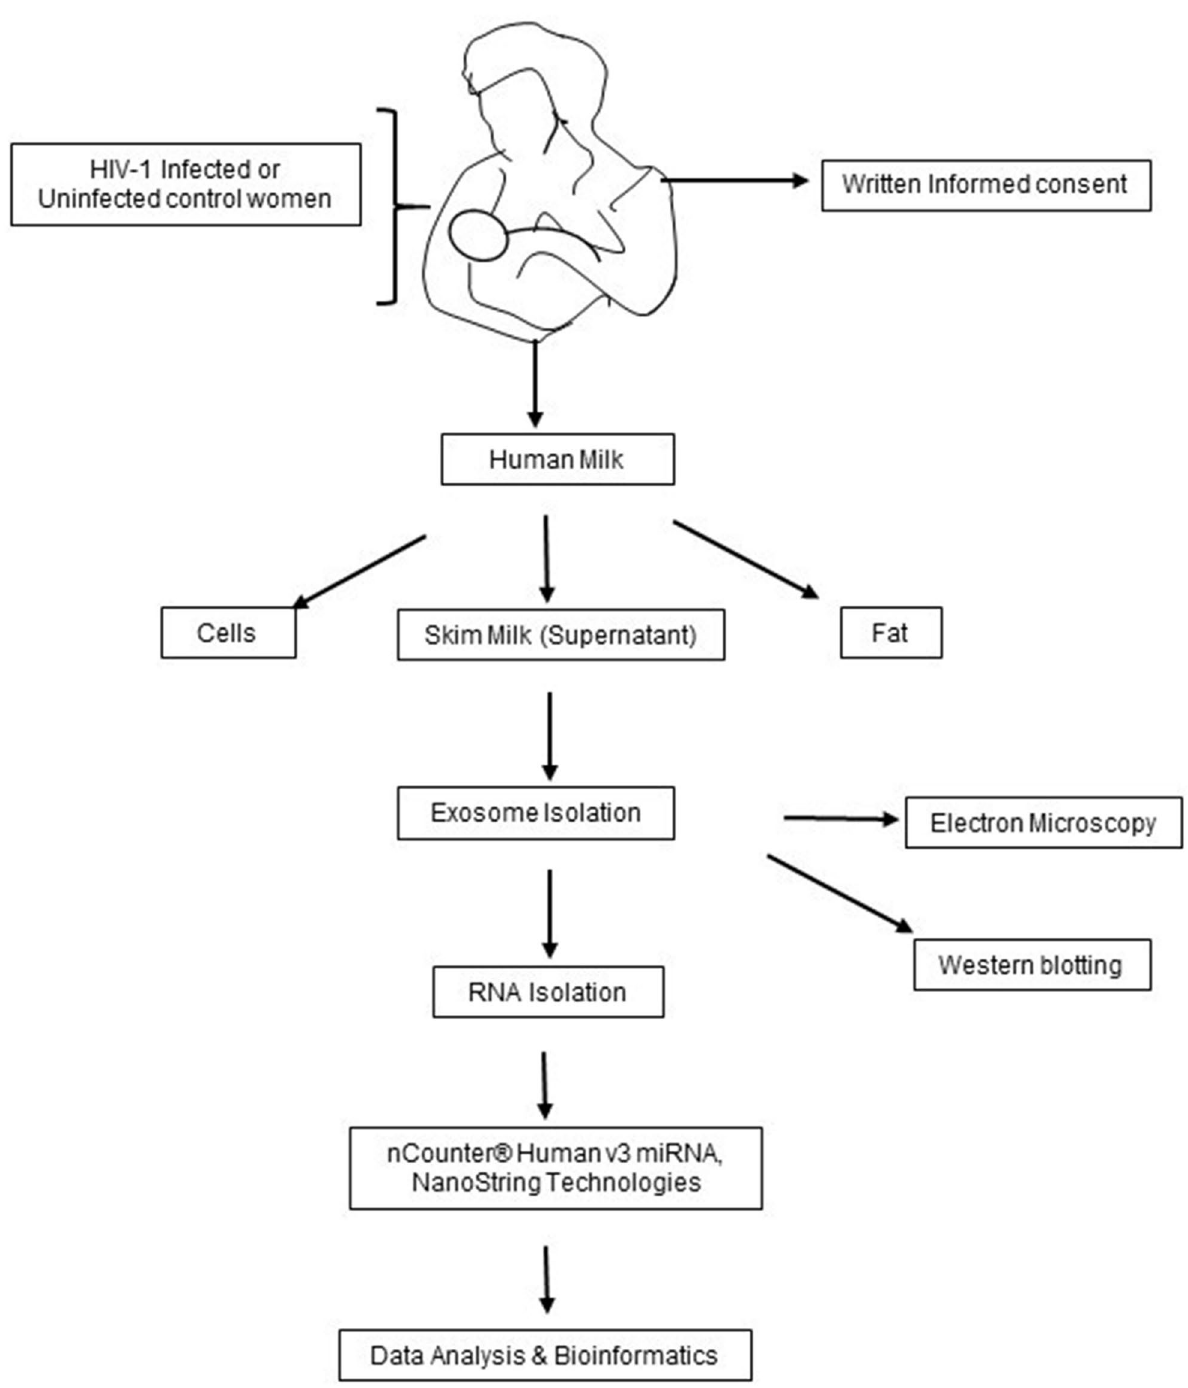
Figure 1. Schematic layout of the methodology adopted for Human Milk Exosomal miRNA Profiling. Human milk samples were collected from HIV-1 infected and uninfected control women from Nigeria. The samples were processed for exosome isolation and confirmed either by electron microscopy or by Western blotting using Exosomal marker protein CD81. Exosomal RNAs were extracted, subjected to integrity check by Bioanalyzer and run for miRNA profiling using nCounter Nanostring Human v3.0. The data were analyzed, and targets were